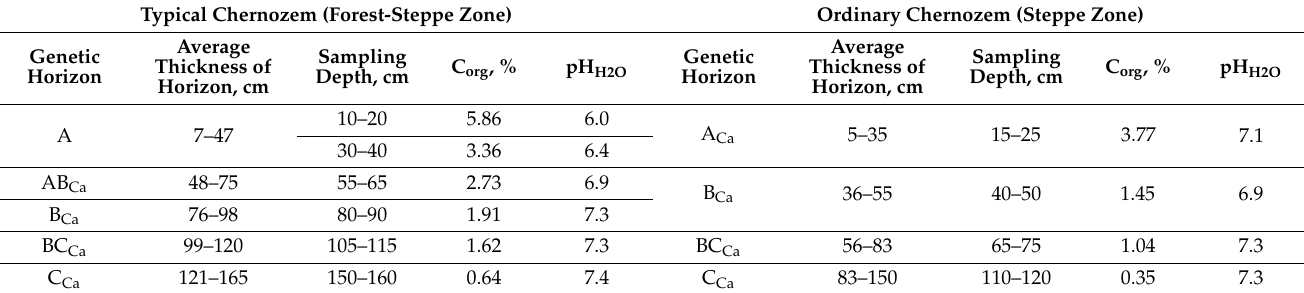
Table 3. Average content of C org and the pH H2O value in soil profiles of reserved chernozems, typical and